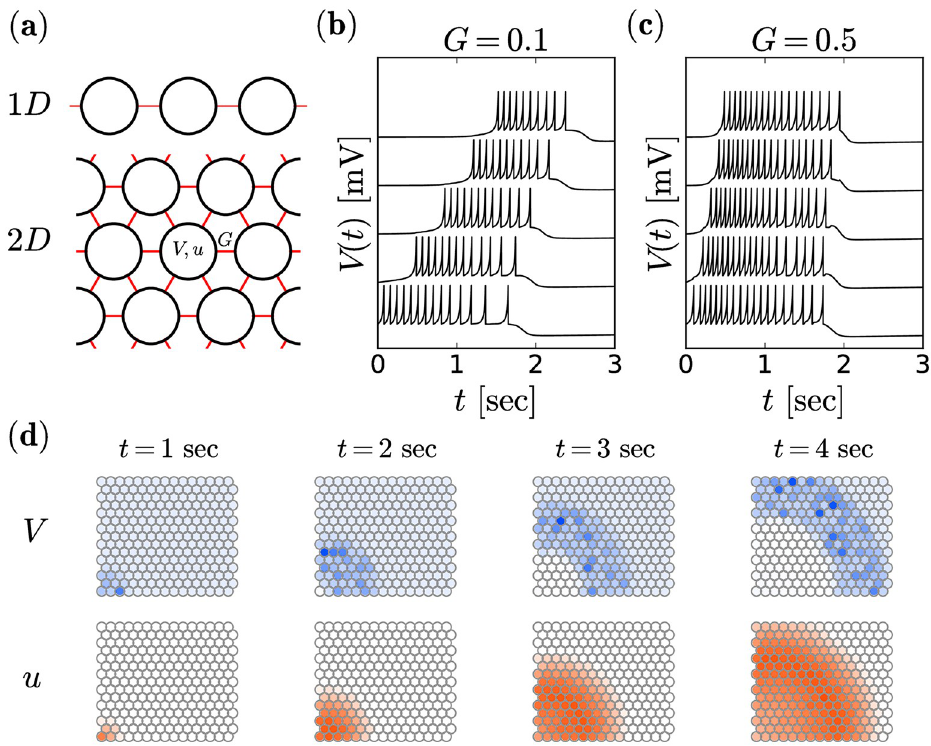
Fig 2. Wave propagation in the deterministic system ( D = 0). Lattice structure of the network shown in (a) for the one-dimensional (1D) and two-dimensional (2D) simulations. Voltage traces of five model neurons (vertically shifted for better visibility), coupled in a one-dimensional chain with G = 0.1 (b) and G = 0.5 (c) . The respective first neuron (bottom trace) was initialized in the bursting regime, i.e. ( u ( t = 0), V ( t = 0)) = ( u two-dimensional triangular lattice (voltage and recovery variable in top and bottom panels, respectively) with G = 0.1 at different time instances as indicated (d) .